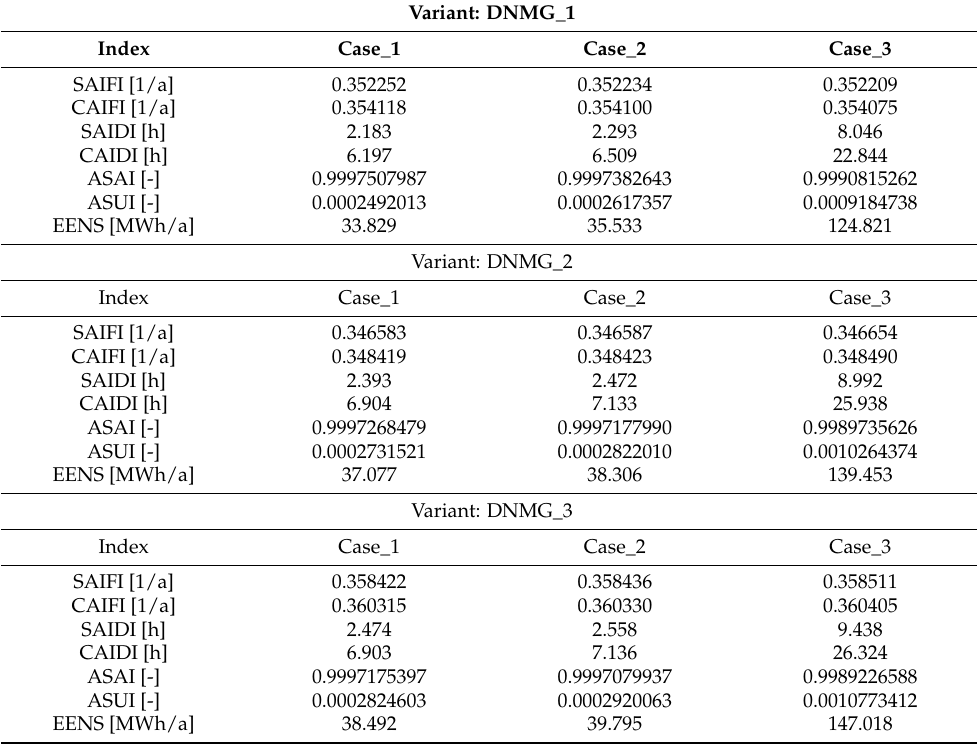
Table 11. Reliability system indices for DNMG structure (Figure A4).